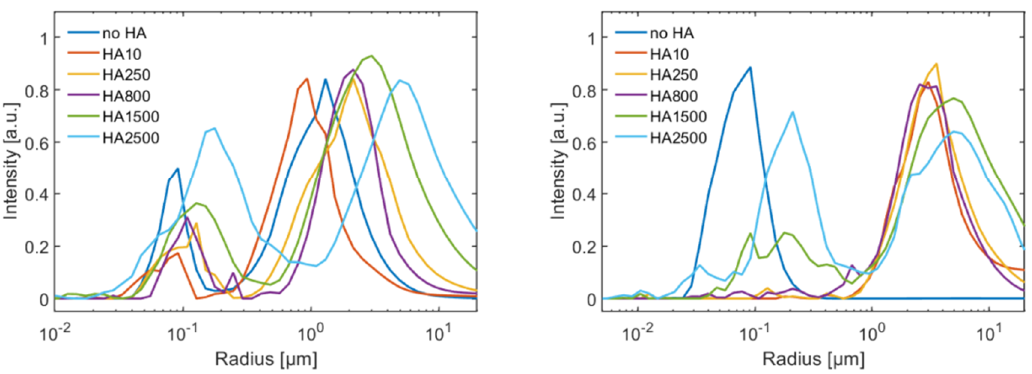
Figure 3. DLS data of the vesicle-HA aggregates as a function of the MW of HA. ( Left ) sodium chloride solutions (150 mM) and ( right ) sodium chloride with calcium chloride (150 mM / 10 mM).